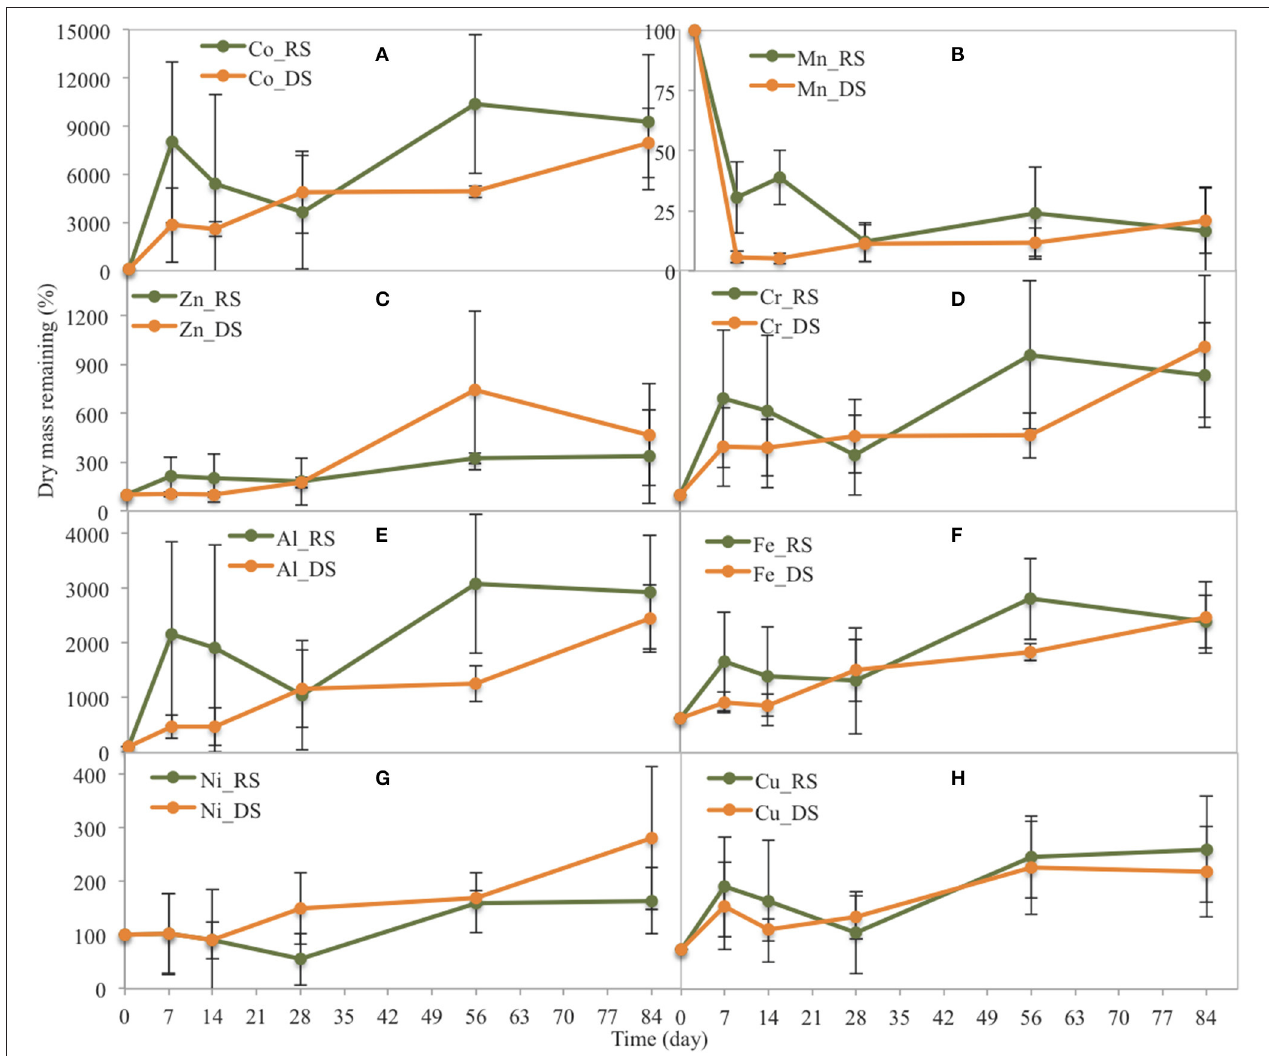
FIGURE 6 | Changes in the dry mass of some trace metals related to their original dry mass in yellow leaves during leaf litter decomposition in the Rhizophora stand at the two seasons (DS: dry season, RS: rainy season). (A) Co, (B) Mn, (C) Zn, (D) Cr, (E) Al, (F) Fe, (G) Ni, (H)